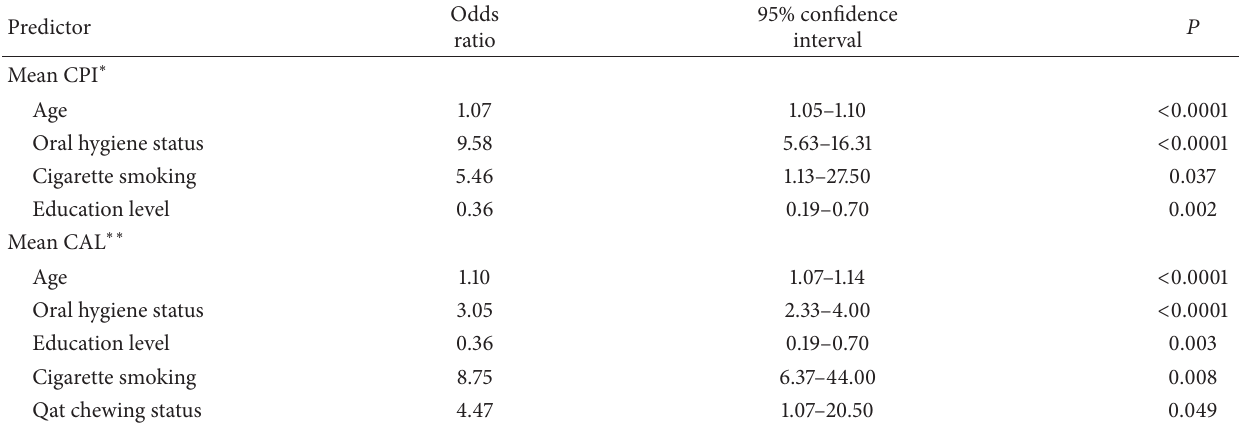
Table 5: Independent predictors of mean CPI and CAL—multiple ordinal logistic regression model # .